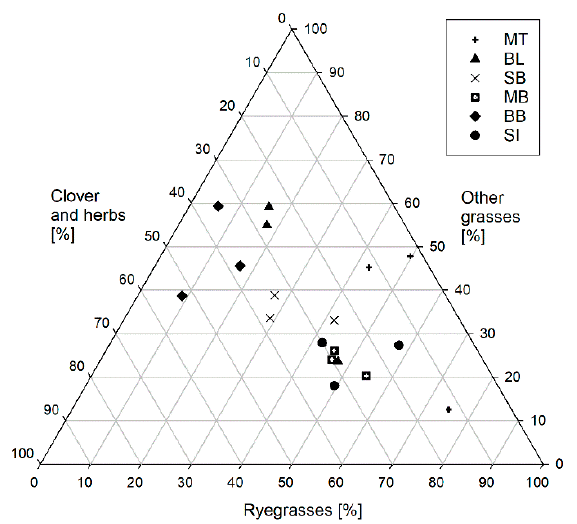
Figure 1. Relative abundance of ryegrasses, other grasses, and clover and herbs in the 18 studied grasslands, which were distributed over six commercial farms (MT, BL, SB, MB, BB, and SI). The values are the average values from the botanical surveys in spring and late summer 2018.